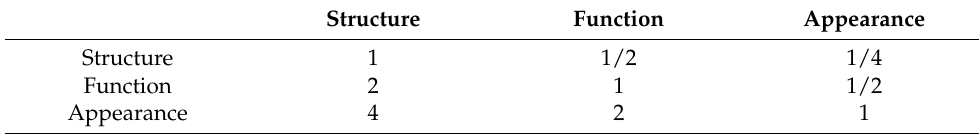
Table 6. The customer bias in the evaluation matrix.